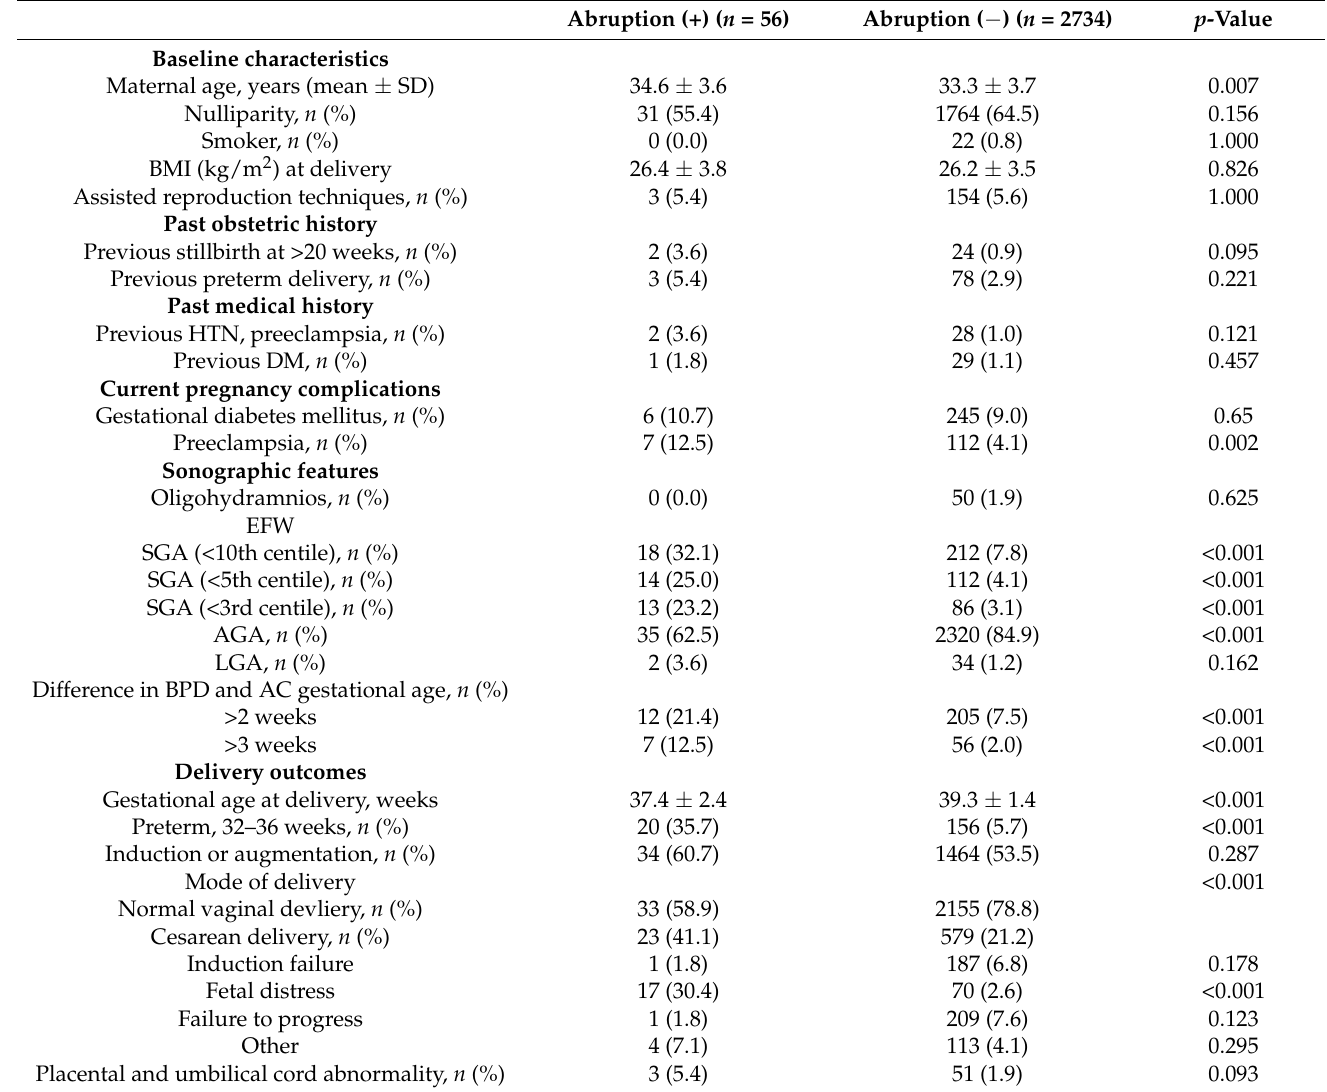
Table 1. Comparison of the baseline characteristics, sonographic features, and delivery outcomes according to placen- tal abruption.